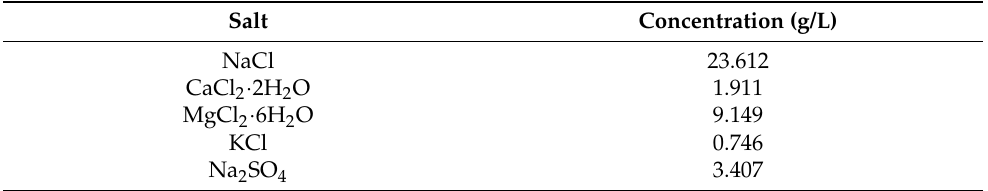
Table 1. Synthetic seawater